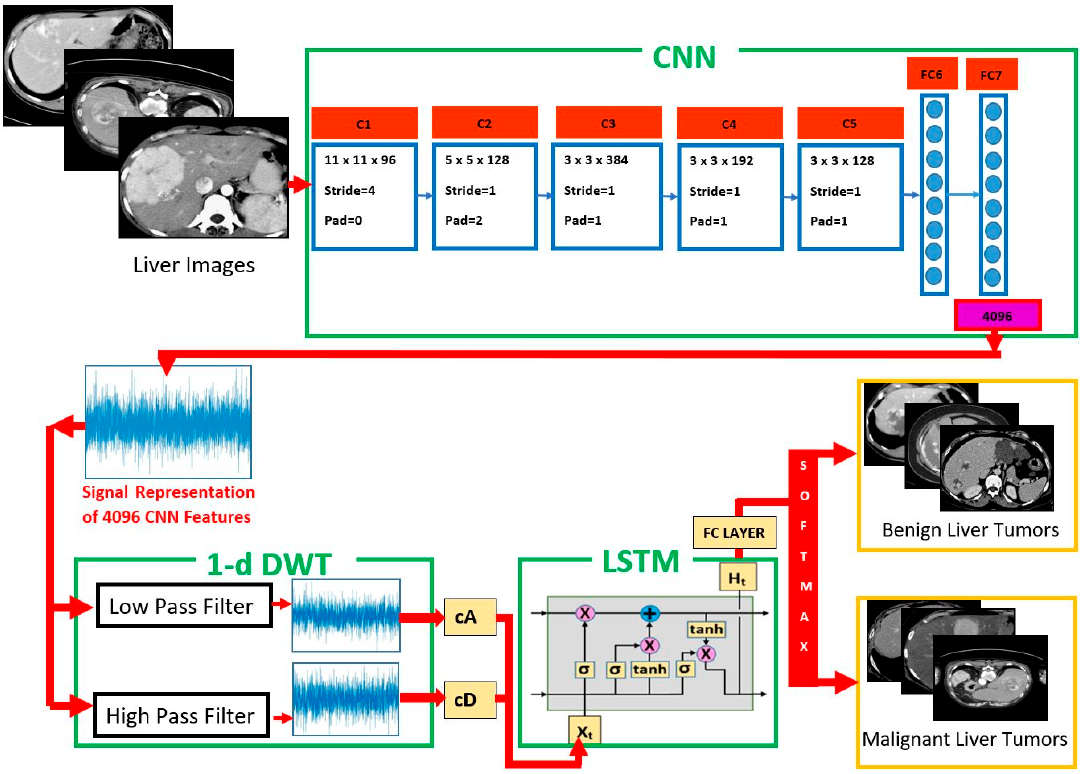
Figure 1. Proposed convolutional neural network (CNN)–discrete wavelet transform (DWT)–long short-term memory (LSTM) architecture for liver tumor classification.